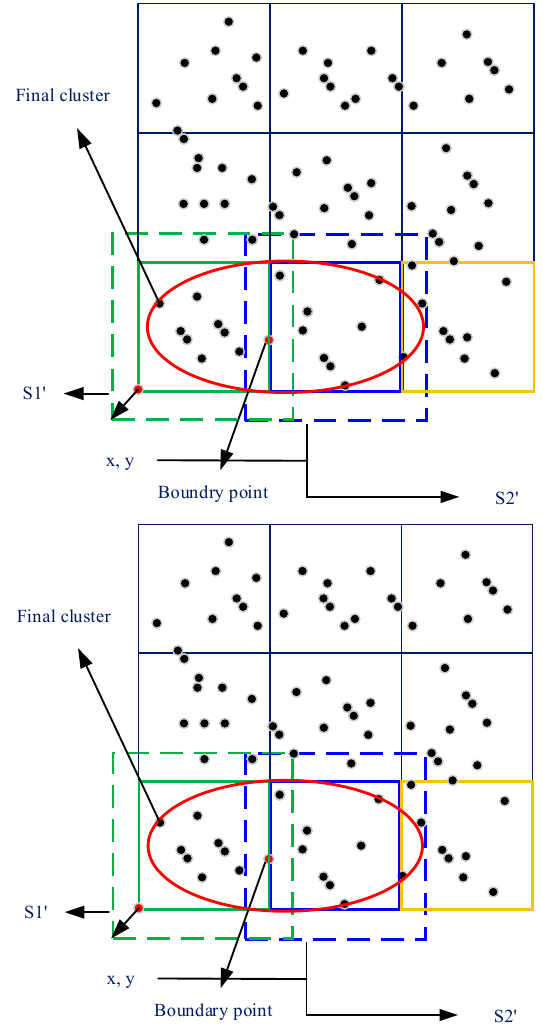
Figure 12. A global cluster generation stage.